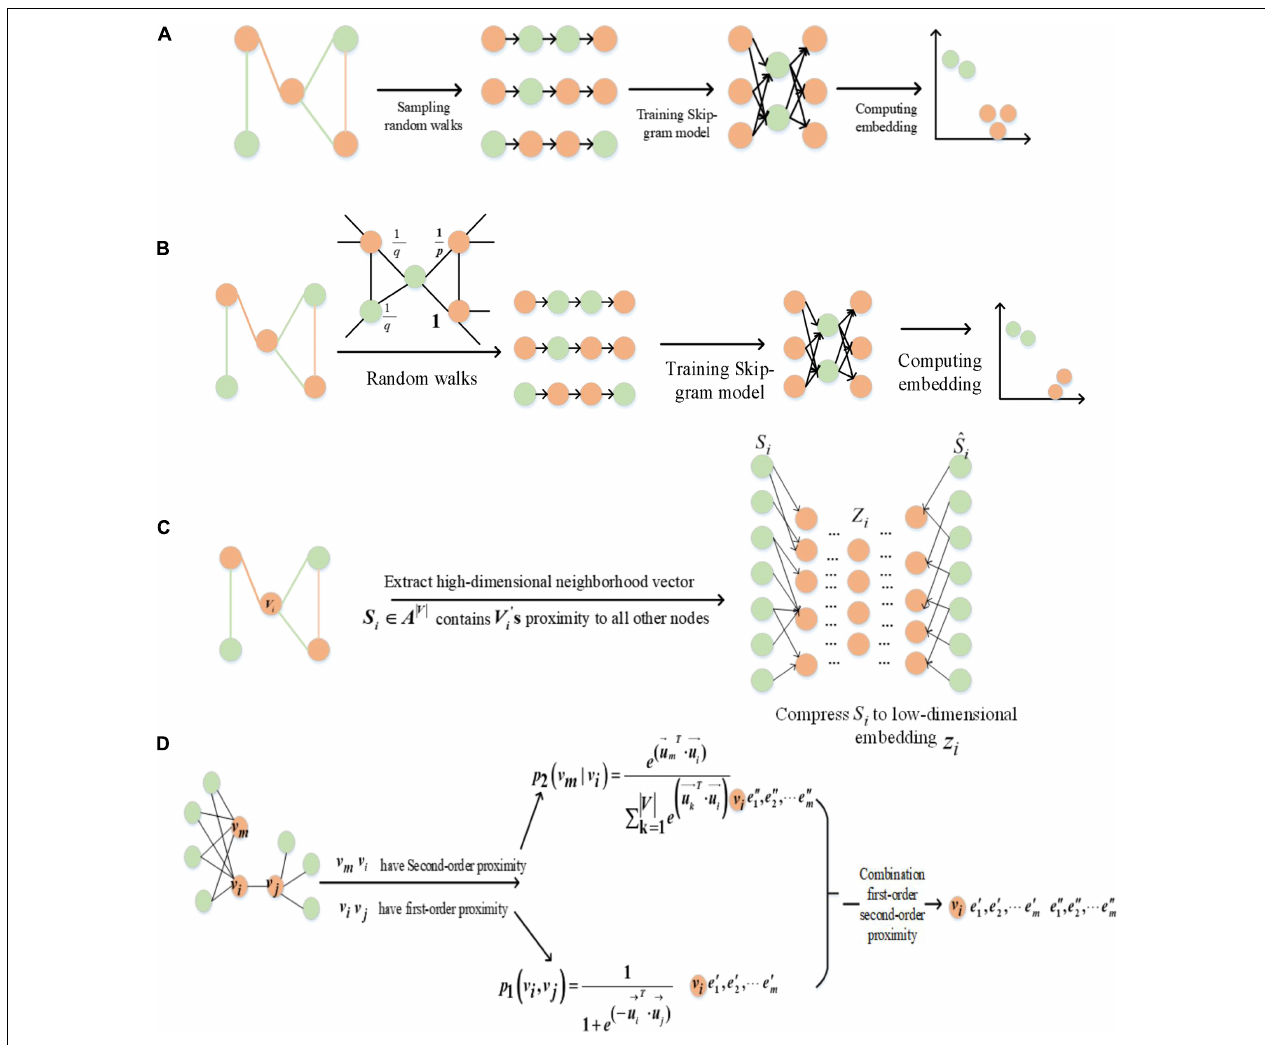
FIGURE 2 | Framework for graph embedding method. (A) DeepWalk, (B) Node2vec, (C) SDNE, and (D) LINE.